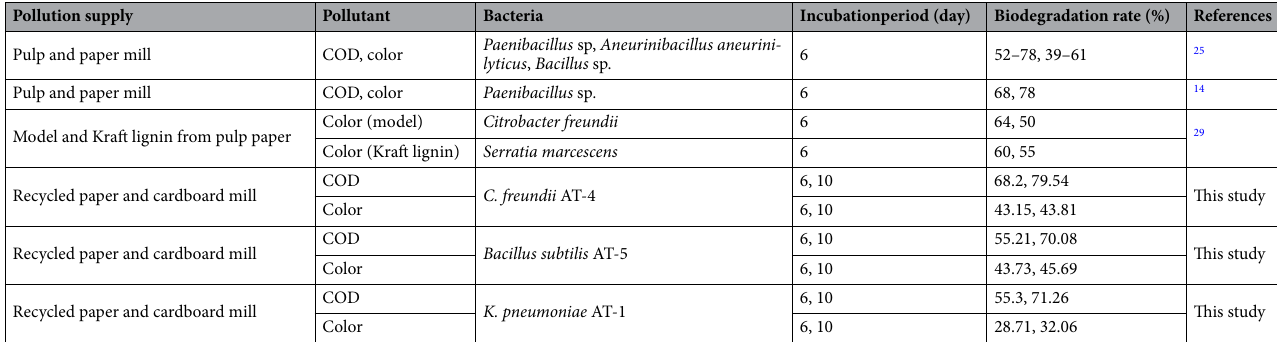
Table 6. The maximum COD and color biodegradation by different bacterial